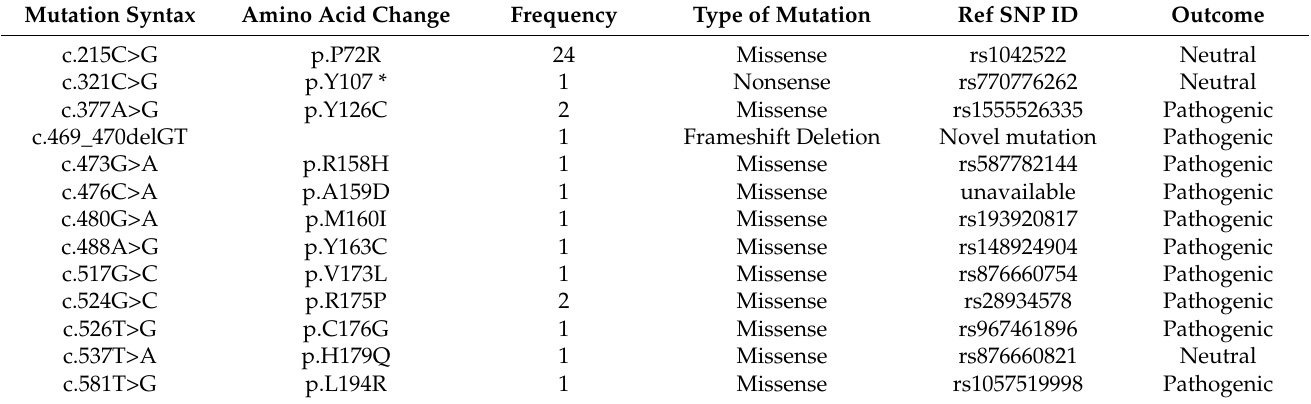
Table 2. TP53 mutation information and their pathogenic